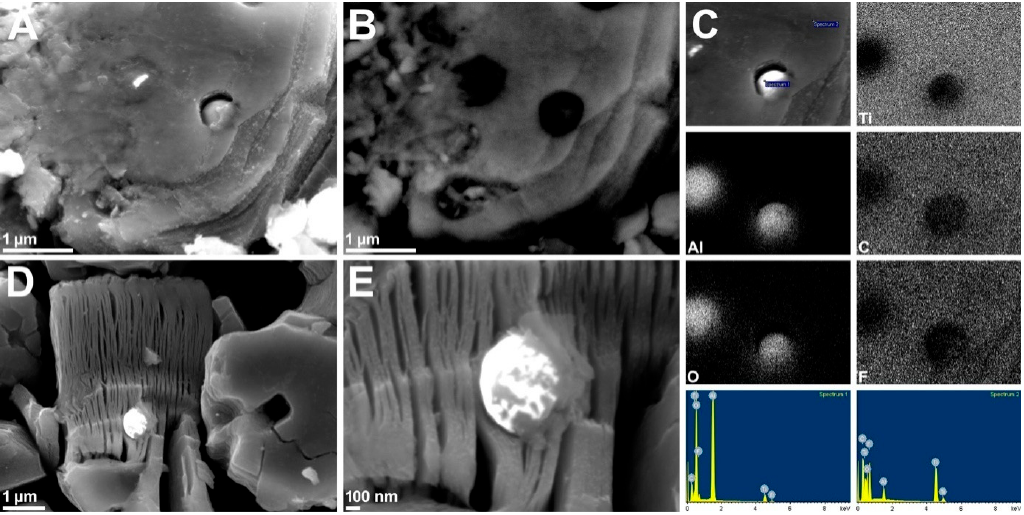
Figure 3. SEM micrographs of Ti 3 C 2 T x -Air in SEI ( A , D , E ), COMPO ( B ) modes, and EDS analyses ( C ).